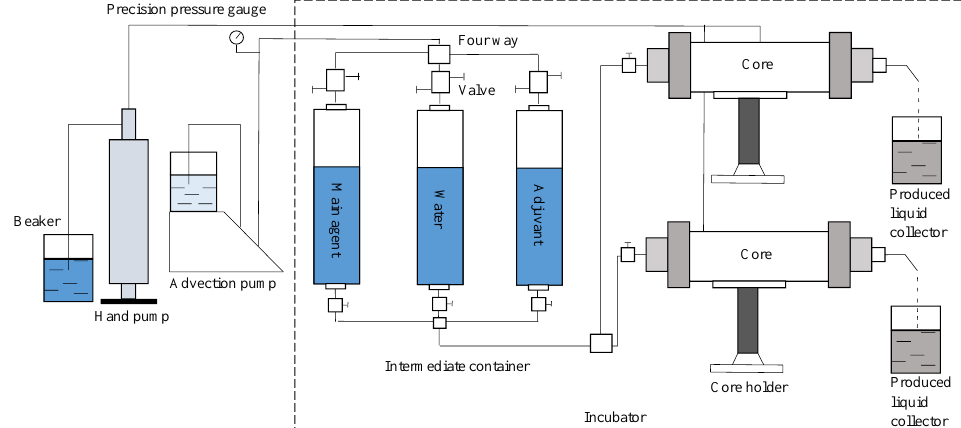
Figure 13. Schematic diagram of the experimental equipment and process.